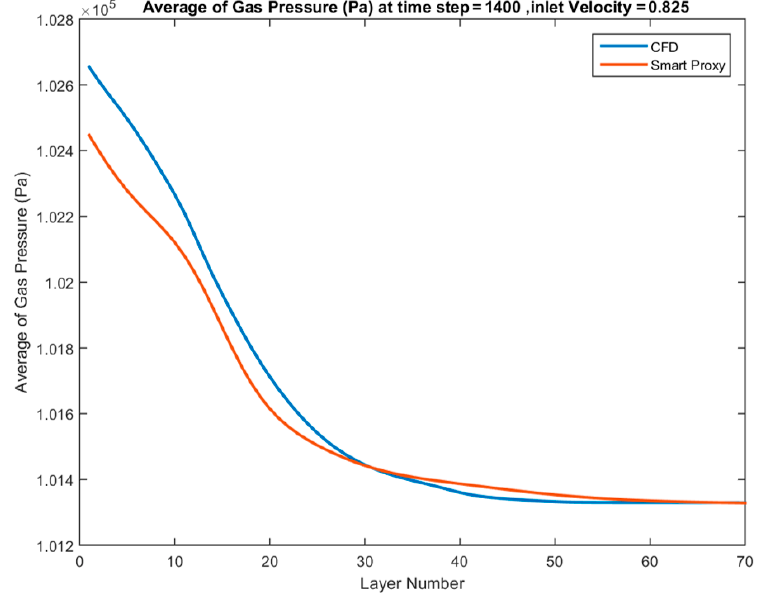
Figure 34. Spatially averaged CFD and smart proxy results for gas pressure (Pa) at time step = 1400 for blind test condition of V in = 0.825 m/s (with four static parameters).